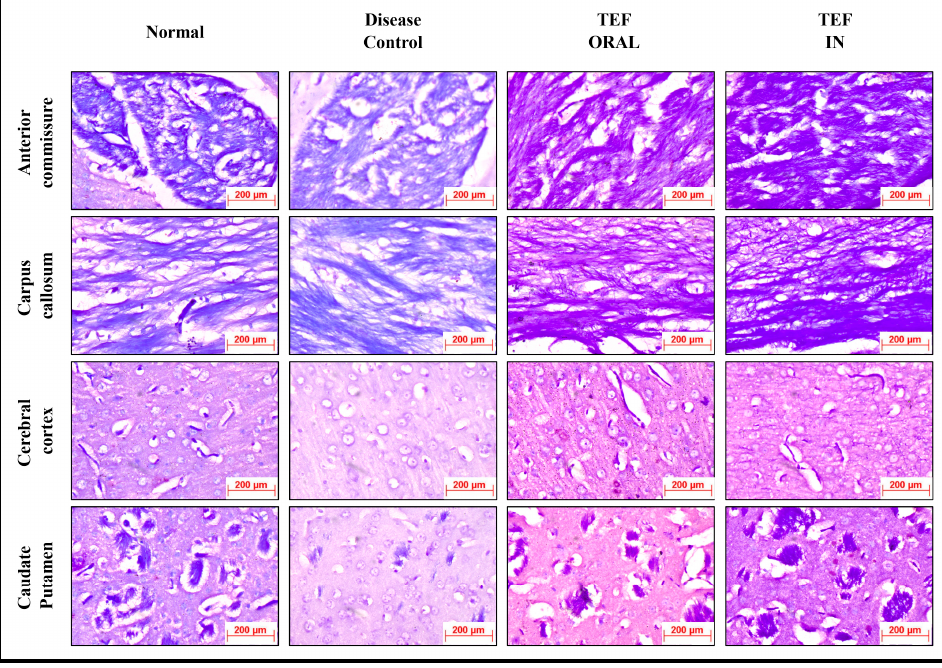
Figure 8. The unbiased semi-quantitative scoring for the histopathological sections where (0) corre- sponds to no demyelination and in fl ammation and (5) indicates complete demyelination and in- fl ammation. The IN administered TEF–miR-155-antagomir-loaded NLCs group has exhibited sig- ni fi cant ( p < 0.002) recovery with minimal in fl ammation and demyelination compared to TEF oral group. The cuprizone-treated disease control group was observed with a severe immunore- activity of GFAP in the astrocytes and glial cells of the CE region with almost 90% of the glial cells having expressed GFAP protein. However, only a mild immune reactivity of GFAP protein was noted in glial cells of the midbrain with more than 90% of glial cells showing an expression of GFAP protein in the midbrain. Additionally, severe immune reactivity of GFAP protein was observed in glial cells in the region of HC compared to the sections of the normal group with no cuprizone treatment. However, the TEF IN group has exhibited normal immune reactivity of GFAP protein in glial cells of the CE region with less than 25% expression of GFAP protein. Correspondingly, the midbrain region has